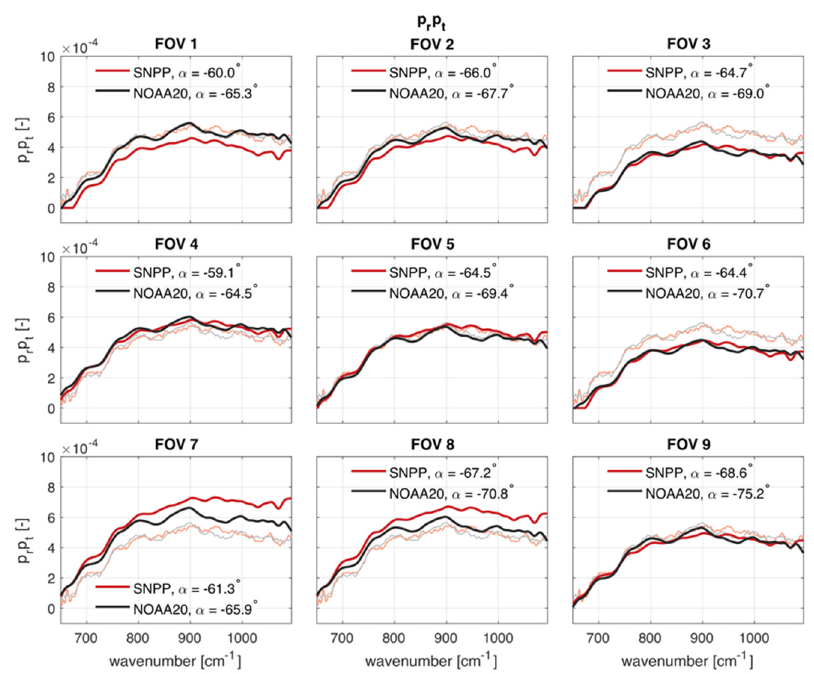
Figure 14. Combined scene select mirror and sensor polarization ( p r p t ) and sensor polarization angle derived from the longwave pitch maneuver data. SNPP is shown in red, and NOAA-20 is shown in black. The lighter weight lines are the derived p r p t values for the average over all nine detectors, with no noise filtering or spectral averaging applied.